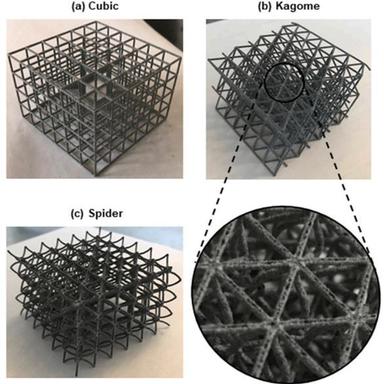
3D printed PA12 lattice structures produced using MJF technology.